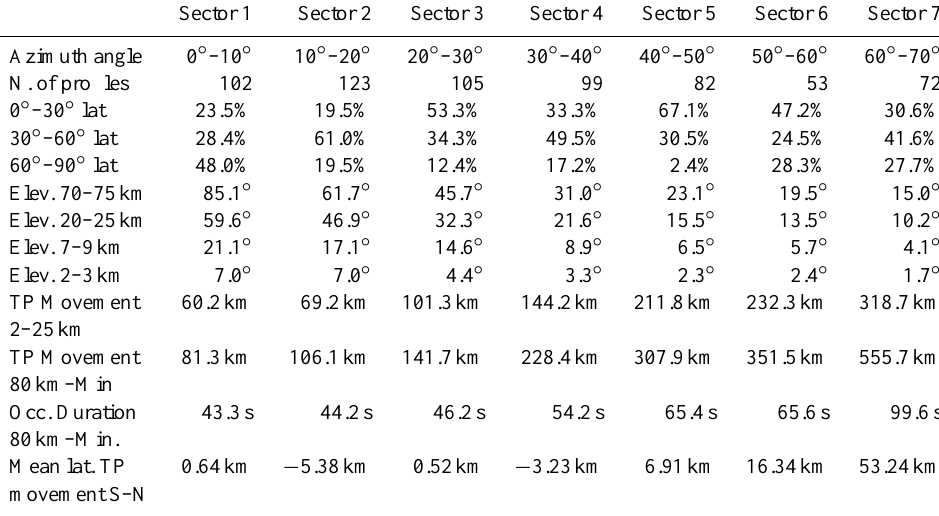
Table 1. Distribution of the occultation events in the seven azimuth sectors and mean characteristics of the tangent point trajectories: azimuth angles of the sectors; number of profiles in each sector; percentage of profiles at low, mid, and high latitudes; mean elevation angle of the tangent point trajectories in four altitude levels; mean tangent point movement between 25km and 2km altitude; mean tangent point movement between 80km and the minimum altitude; mean duration of the occultation events between 80km and the minimum altitude; mean latitudinal tangent point movement between 80km and the minimum altitude (positive for South-North